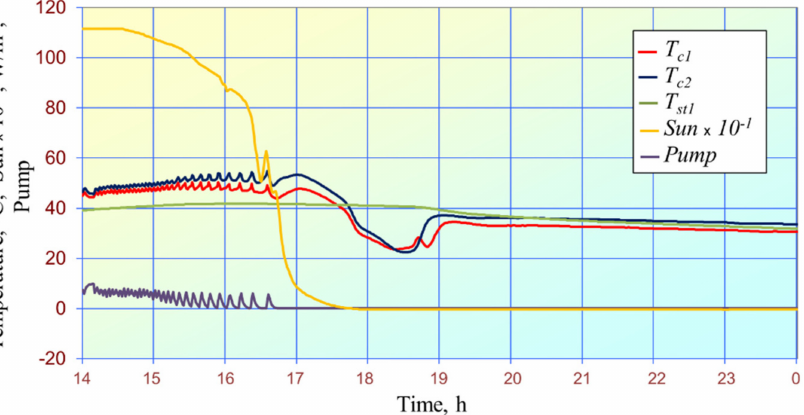
Figure 16. Natural convection in the hydraulic circuit with an open solenoid valve (3 November 2019).